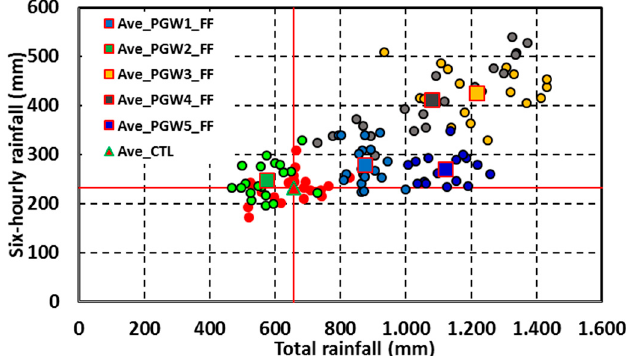
Figure 9. Simulation results of maximum six-hourly and total rainfall from 00:00 UTC 01 October to 18:00 UTC 04 October of the CTL runs and five PGWs models, in the future simulation in D02. The x- axis is total rainfall and the y-axis is maximum six-hourly rainfall. The unit is mm.